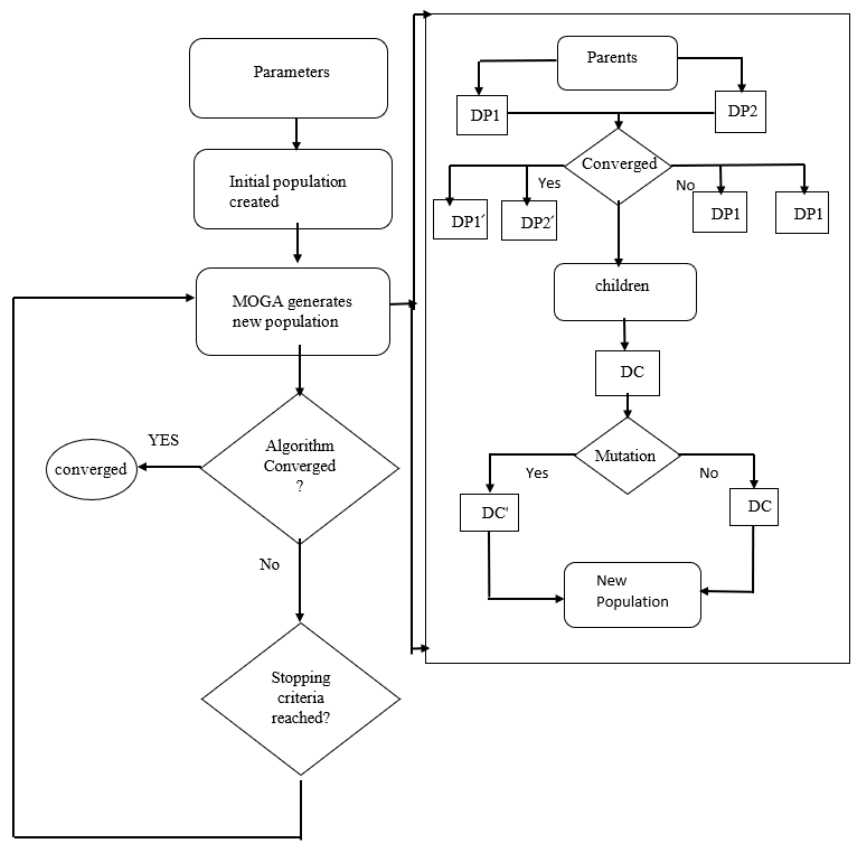
Figure 4. The MOGA workflow [28,31], DP new population that MOGA generates.